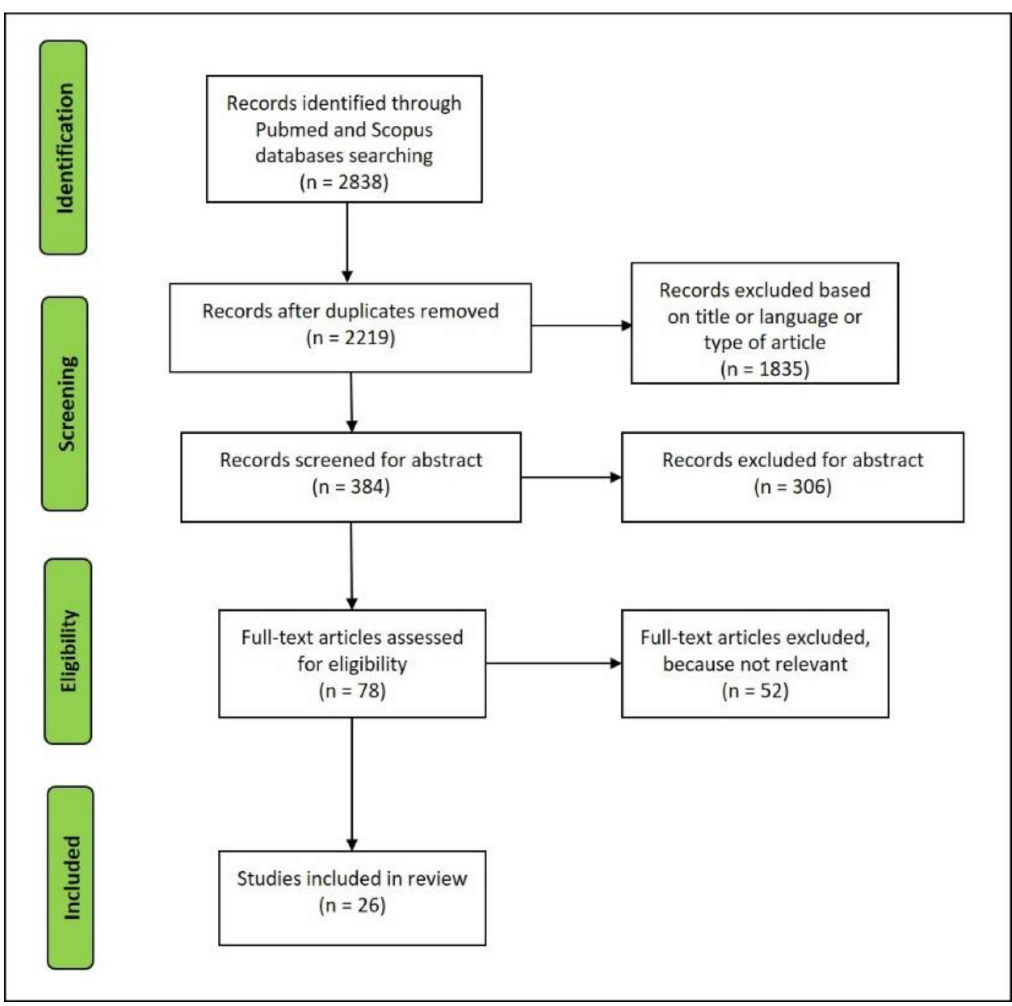
Figure 3. Flowchart of the studies retrieved for the